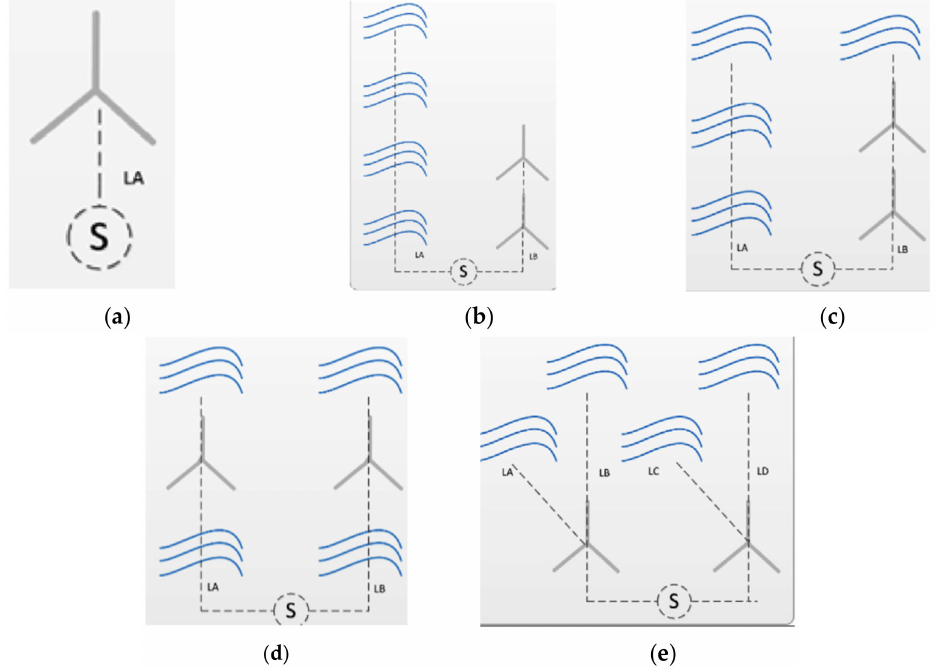
Figure 5. Configuration of the farm inputs [35]: one renewable energy ( a ), two renewable energies and independent arrays ( b ), two renewable energies and peripherally distributed arrays ( c ), two renewable energies and uniformly distributed arrays ( d ), and two renewable energies and non-uniformly distributed arrays ( e